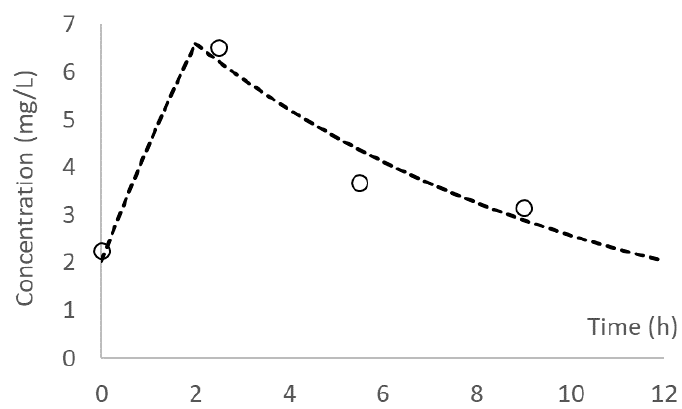
Figure 1. A typical pharmacokinetic profile: open circles depict observed data, and the dashed line represents the best-fit (one compartment) model; r 2 = 0.93.